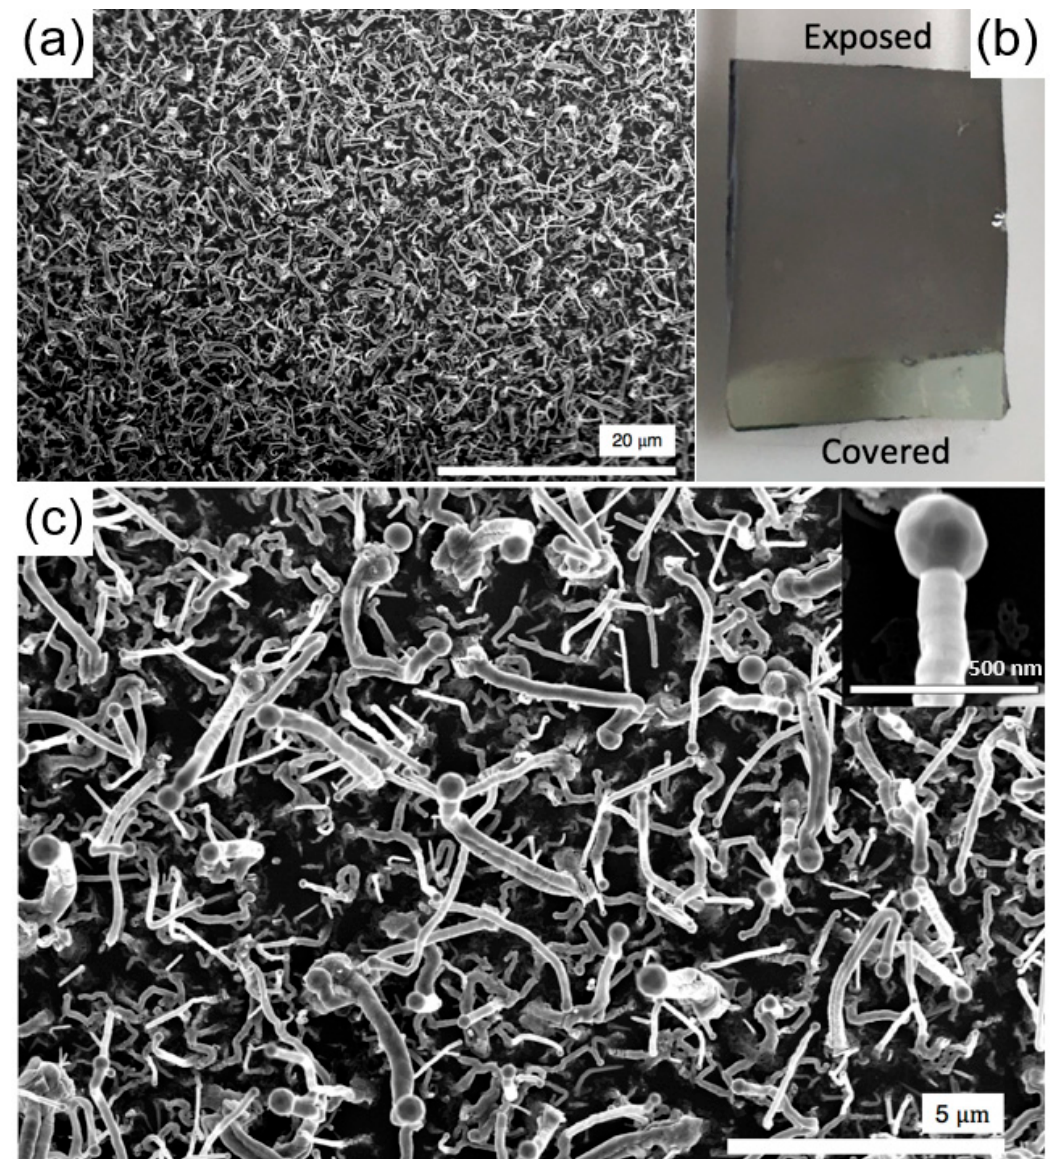
Figure 2. Morphology of the synthesized nanowires. ( a ) Low-resolution SEM image of the nanowires on the substrate. ( b ) Digital photo of a coated Si substrate from the region exposed to the reactants. ( c ) High-resolution SEM image of the nanowires on the substrate. Inset shows an individual Au-capped nanowire—Scale bar = 500 nm. Nanowires were prepared at Ts = 1000 °C for 30 min at D = 8 cm downstream of the Ga2O3 and ZnO source materials.